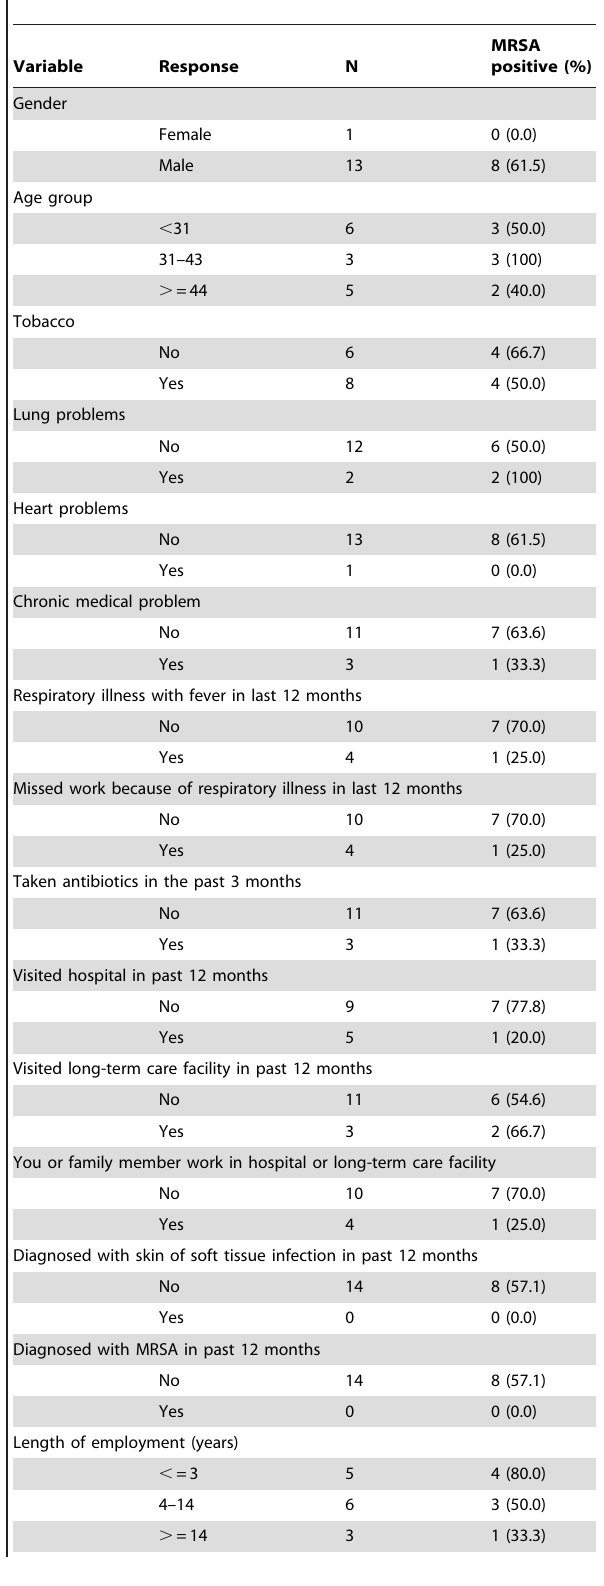
Table 1. Characteristics of Production System A swine workers and MRSA prevalence.